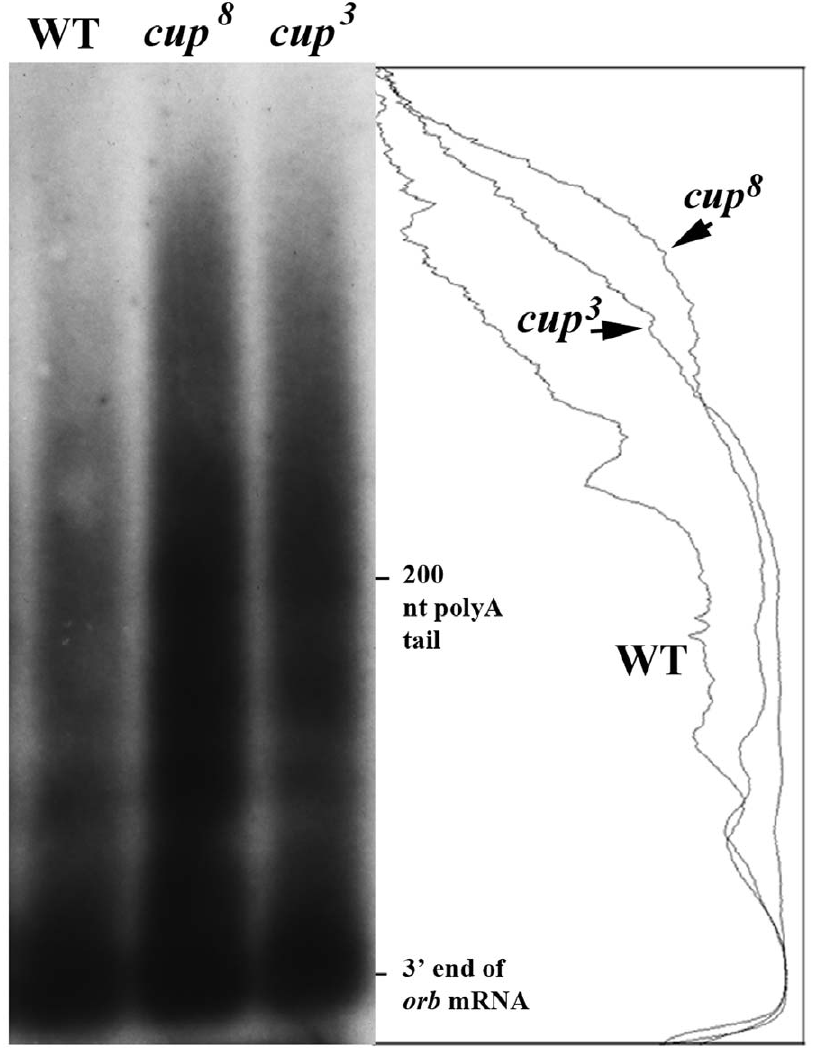
Figure 7. The poly(A) tails of orb in cup 8 and cup 3 mutants are elongated compared to wild type. Poly(A) tails of orb mRNA from wild type, cup 8 and cup 3 (as indicated) were analyzed using the ligation-mediated poly(A)-tail assay [24]. Anchor primers for reverse transcription and amplification from the poly(A) tail were as described in [24]. To increase specificity for the orb 3 9 UTR we used a two step PCR amplification with a nested primer pair derived from the orb 3 9 UTR (F2:GATTGTCCGCTAAGCGTTTATCAGGA and F4:CCTTGTGAACATTAACGCGATG). The orb 3 9 UTR products from the 2 nd PCR amplification were analyzed on an agarose gel, and after blotting to nitrocellulose were detected by hybridizing the filter with a radioactive orb 3 9 UTR probe.